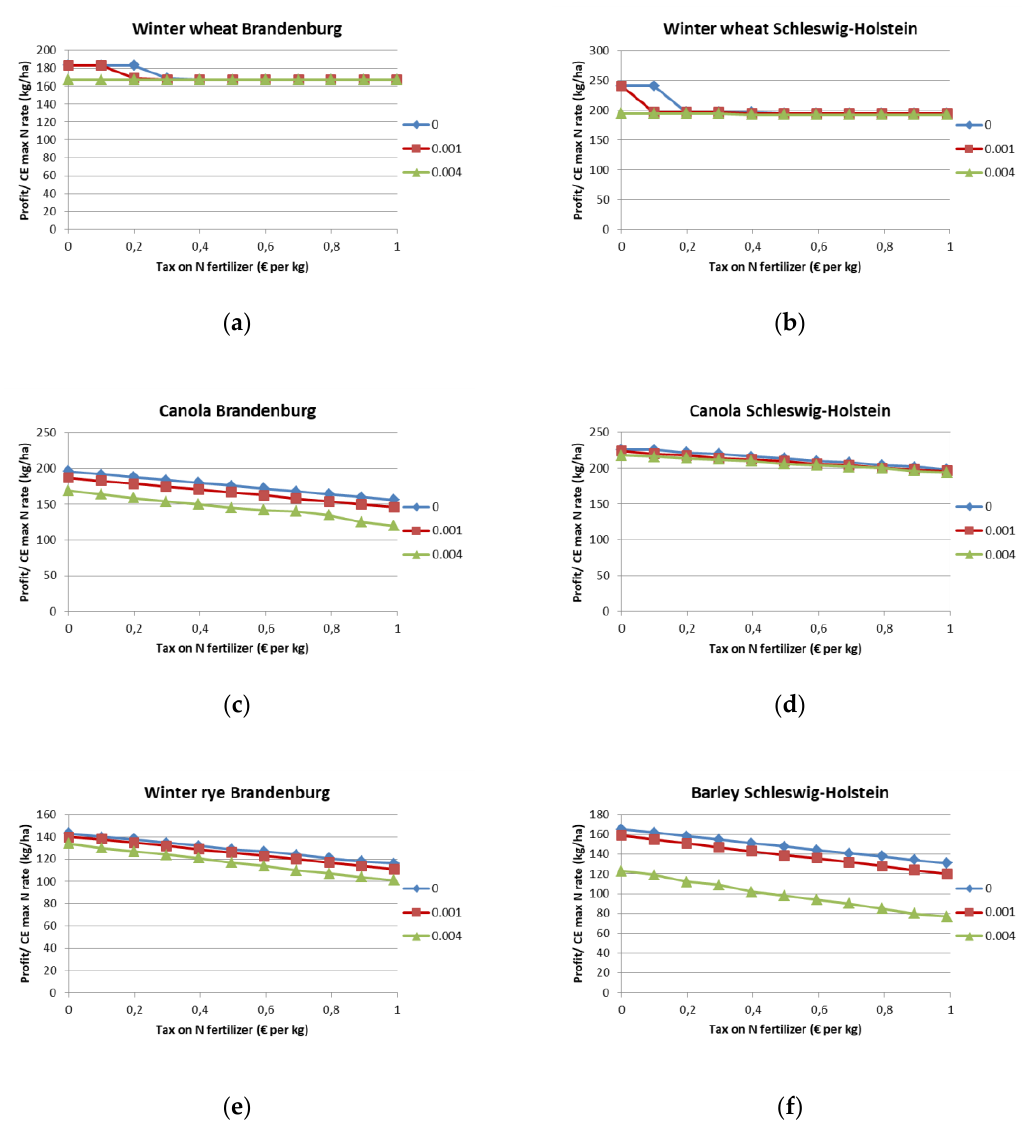
Figure 1. E ff ect of an N tax on economically optimal N rates for di ff erent levels of risk aversion, Figure 1. Effect of an N tax on economically optimal N rates for different levels of risk aversion, based on field experiments in Brandenburg ( a , c , e ) and Schleswig-Holstein ( b , d , f ).